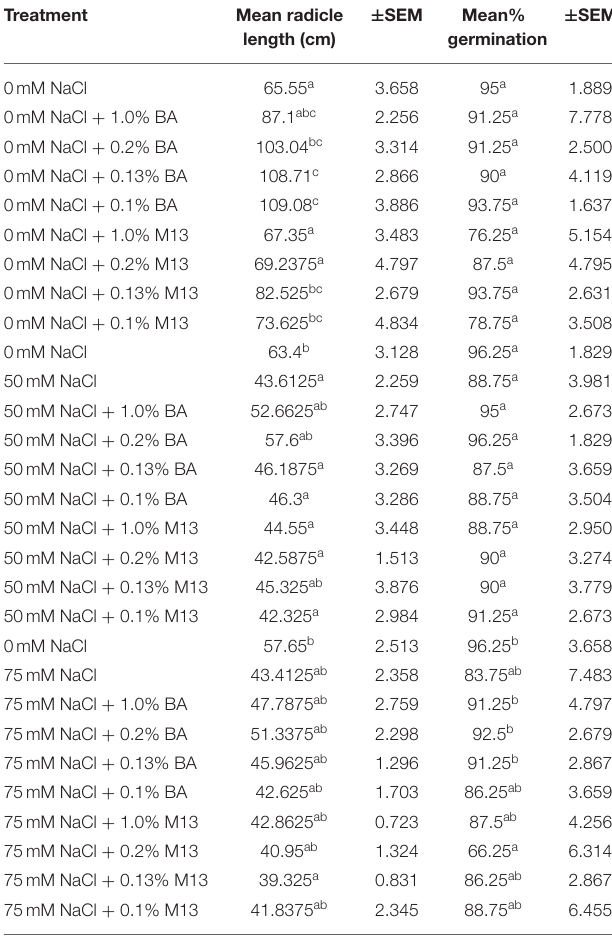
TABLE 3 | Effect of treatment on mean radicle length and mean percentage germination of soybean exposed to 0, 50, and 75mM NaCl, for 72h. Treatment